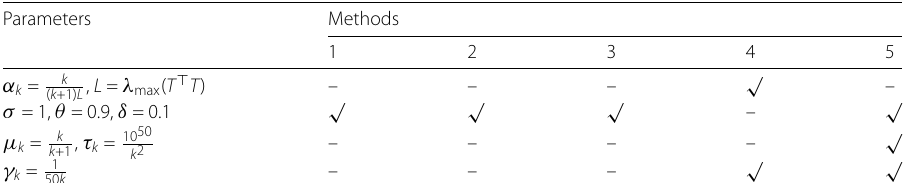
Table 1 The parameters for the deblurring methods Parameters Methods 1 2 3 4